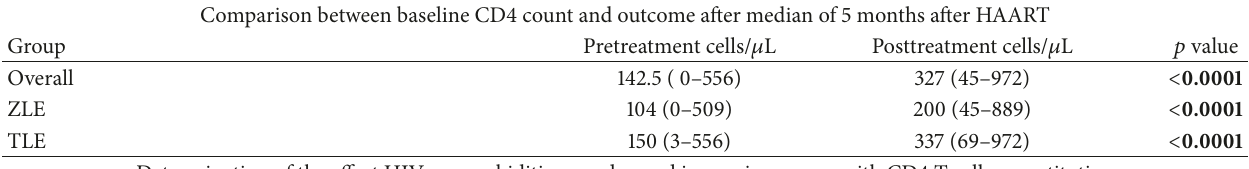
Table 2: Comparison of CD4 T cells count change between treatment groups and how other variables affect CD4 T cells reconstitution following the initiation of